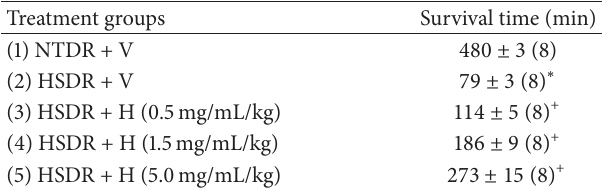
Table 2: The survival time values for normothermic diabetic rats (NTDR) treated with vehicle (NTDR + V), heatstroke-diabetic rats treated with vehicle (HSDR + V), and heatstroke-diabetic rats treated with honokiol (HSDR +